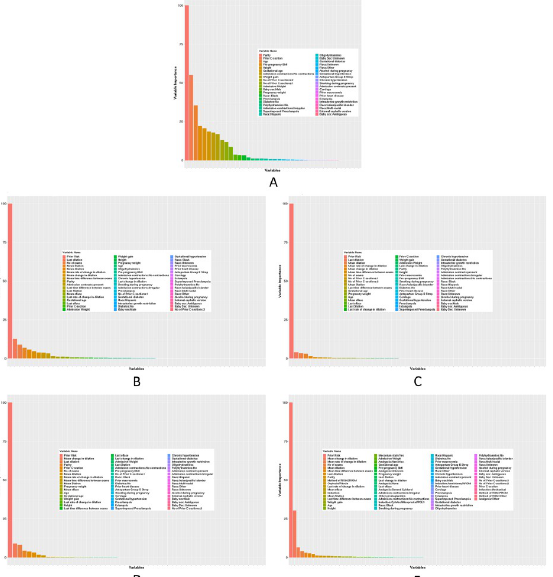
Fig 1. Baseline and intrapartum predictors of composite unfavorable labor outcome and magnitude of contribution to prediction models. A, Prediction model on admission. B, Prediction model at 4 cm cervical dilation. C, Prediction model at 6 cm cervical dilation. D, Prediction model at 8 cm cervical dilation. E, Prediction model at 10 cm cervical dilation.